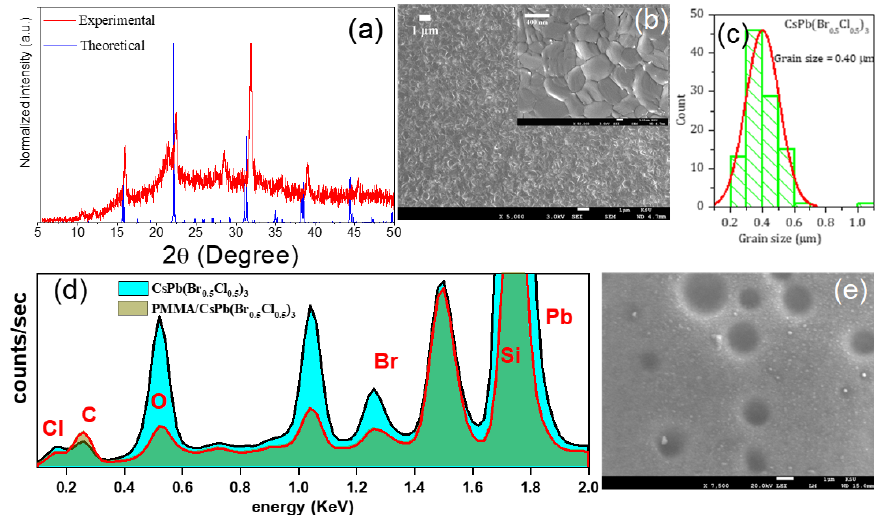
Figure 2. ( a ) X-ray di ff raction (XRD) patterns. ( b ) Scanning electron microscopy (SEM) image of CsPb(Br 0.5 Cl 0.5 ) 3 perovskite thin films (scale bar, 1 µ m), the inset is SEM image with high magnification (scale bar, 400 nm). ( c ) Histogram of the calculated grain size and Gauss fitting curves of the statistical data shown in the SEM image. ( d ) Energy-dispersive X-ray spectroscopy (EDS) spectra for perovskite bare and modified by PMMA polymer. ( e ) SEM image of perovskite film modified by PMMA layer (scale bar, 1 µ